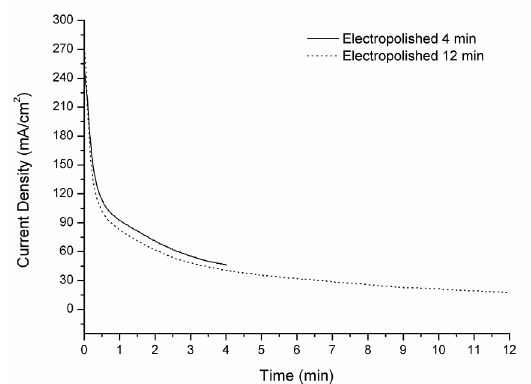
Figure 4. Transients of the current density of the electropolished samples that were treated for 4 min and 12